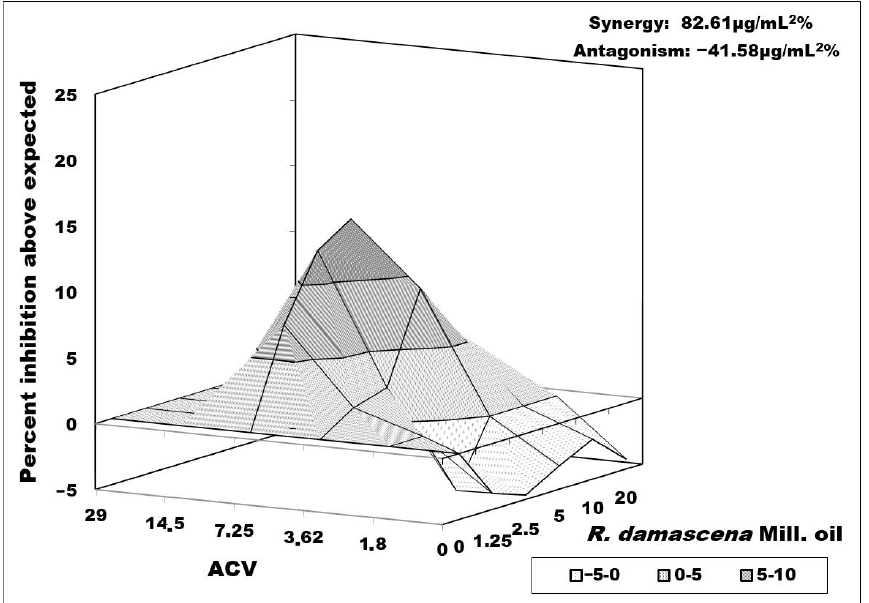
Figure 5. Combined effect of Rosa damascena Mill. oil and acyclovir on HSV-1 replication (R-100 strain—resistant to ACV). Data processing is described in detail in Section 2.10.